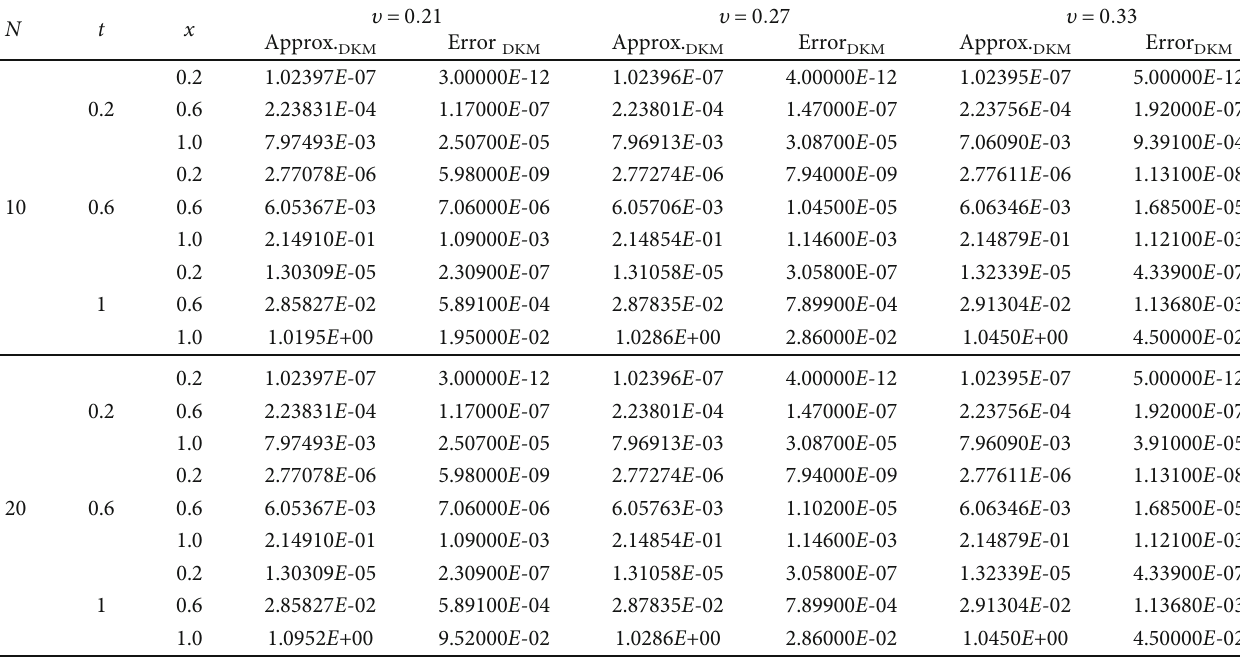
Table 4: The approximate values and the absolute relative error values using DKM method for nonlinear case ( k = 2